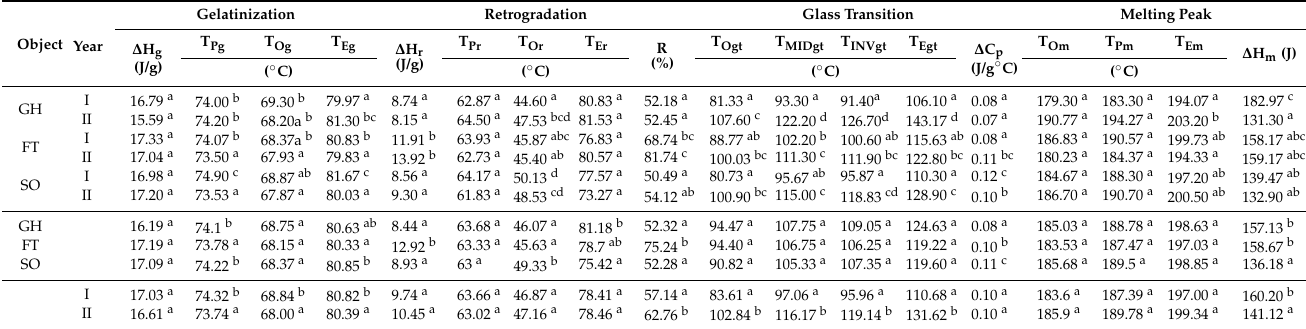
Table 5. Thermal properties of the investigated